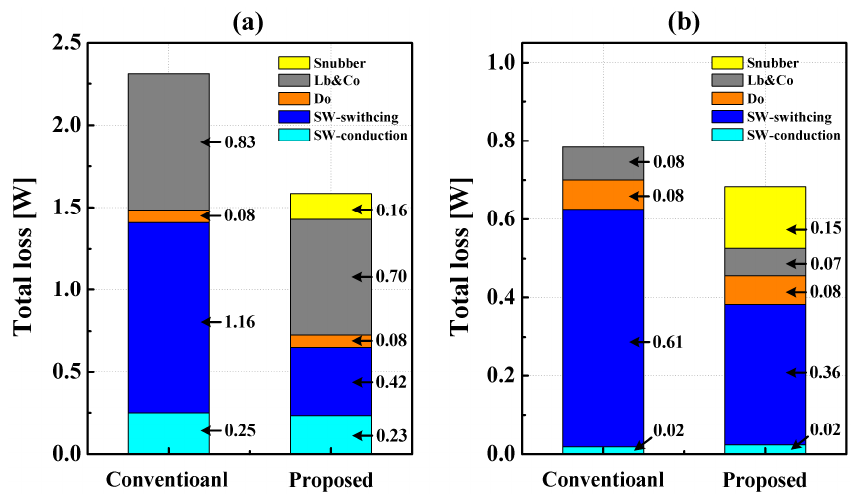
Figure 13. Circuit losses for V O = 40 V, I O = 150 mA and f S = 1 MHz, calculated at ( a ) V IN = 5 V and ( b ) V IN = 15 V.